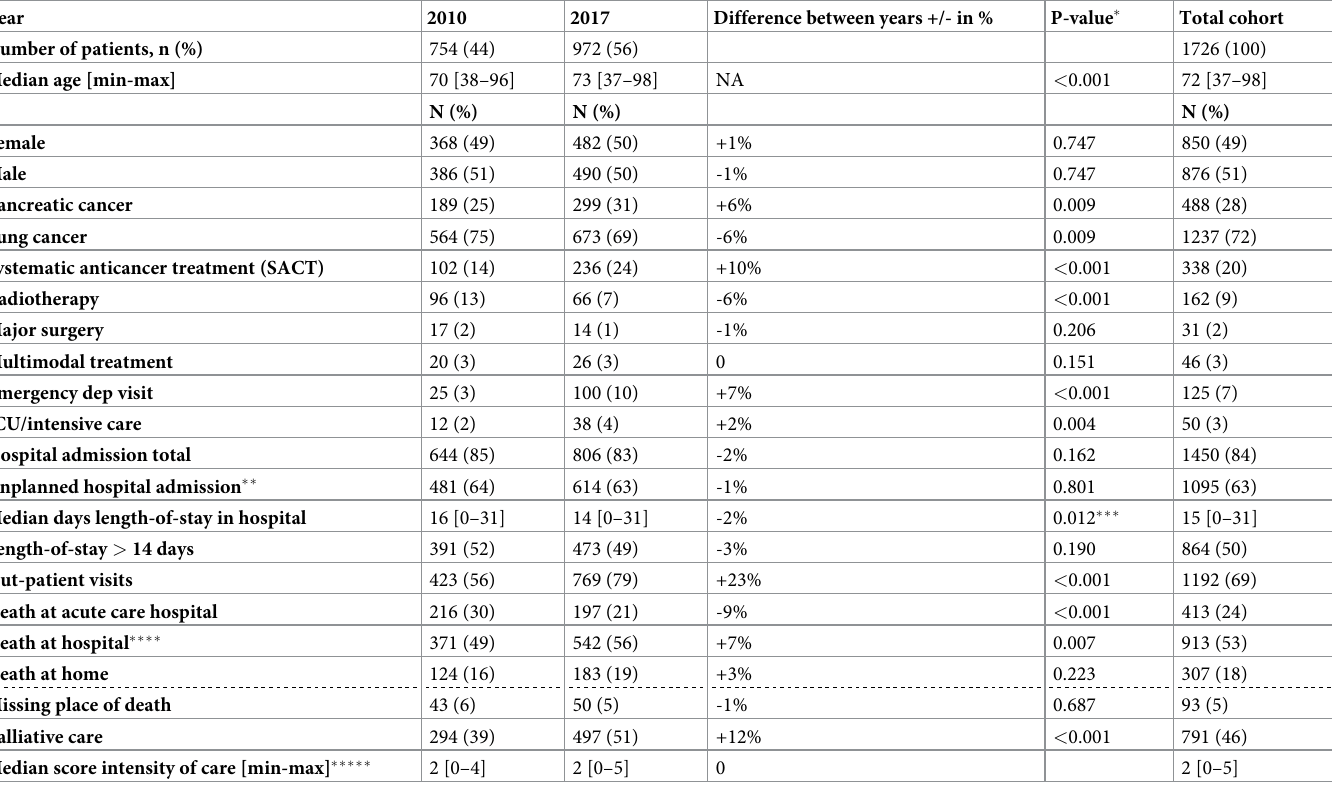
Table 1. Description of the total sample and difference in End-of-life care between the cohorts in the years of 2010 and